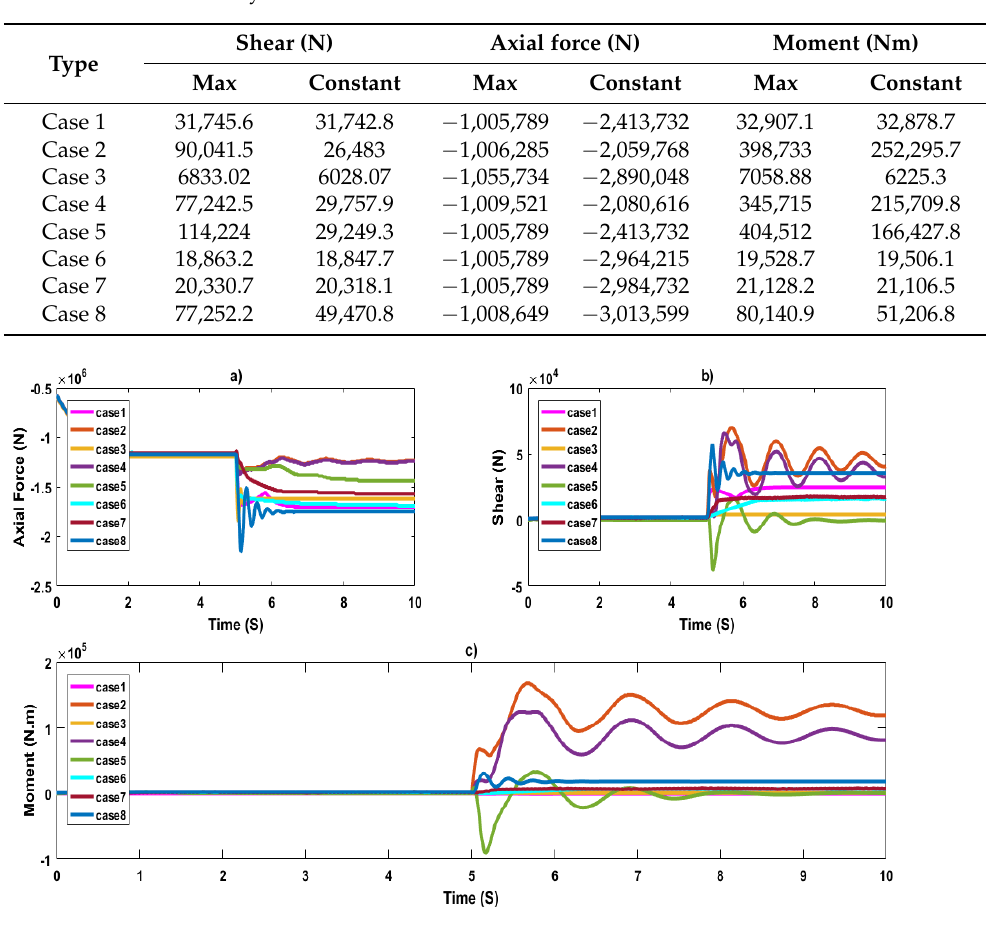
Figure 23. Column behavior after column removal in story six: ( a ) axial force, ( b ) shear, and ( c ) moment. 4. Conclusions In this study, the assessment of different retrofitting approaches on the structural performance of RC buildings against progressive collapse was studied by comparing the eight different cases. The following conclusions are drawn from the results of the analysis: